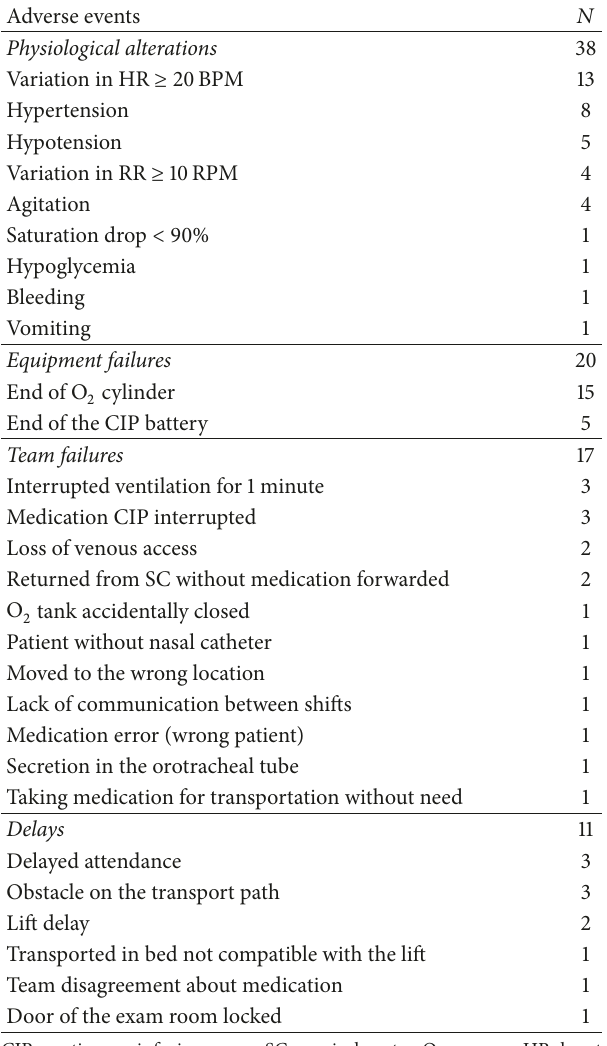
Table 1: Frequency of adverse events observed during intrahospital transport of critically ill patients.